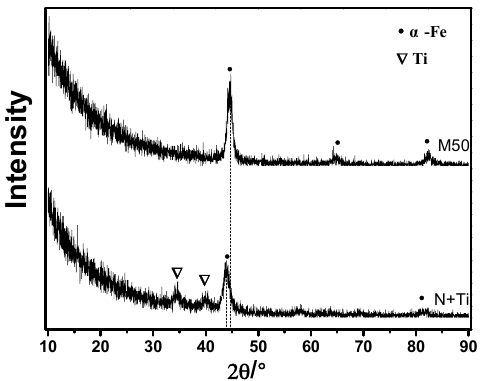
Figure 5. Grazing-incidence XRD results of pristine M50 and implanted sample with an incidence angle of 1°.